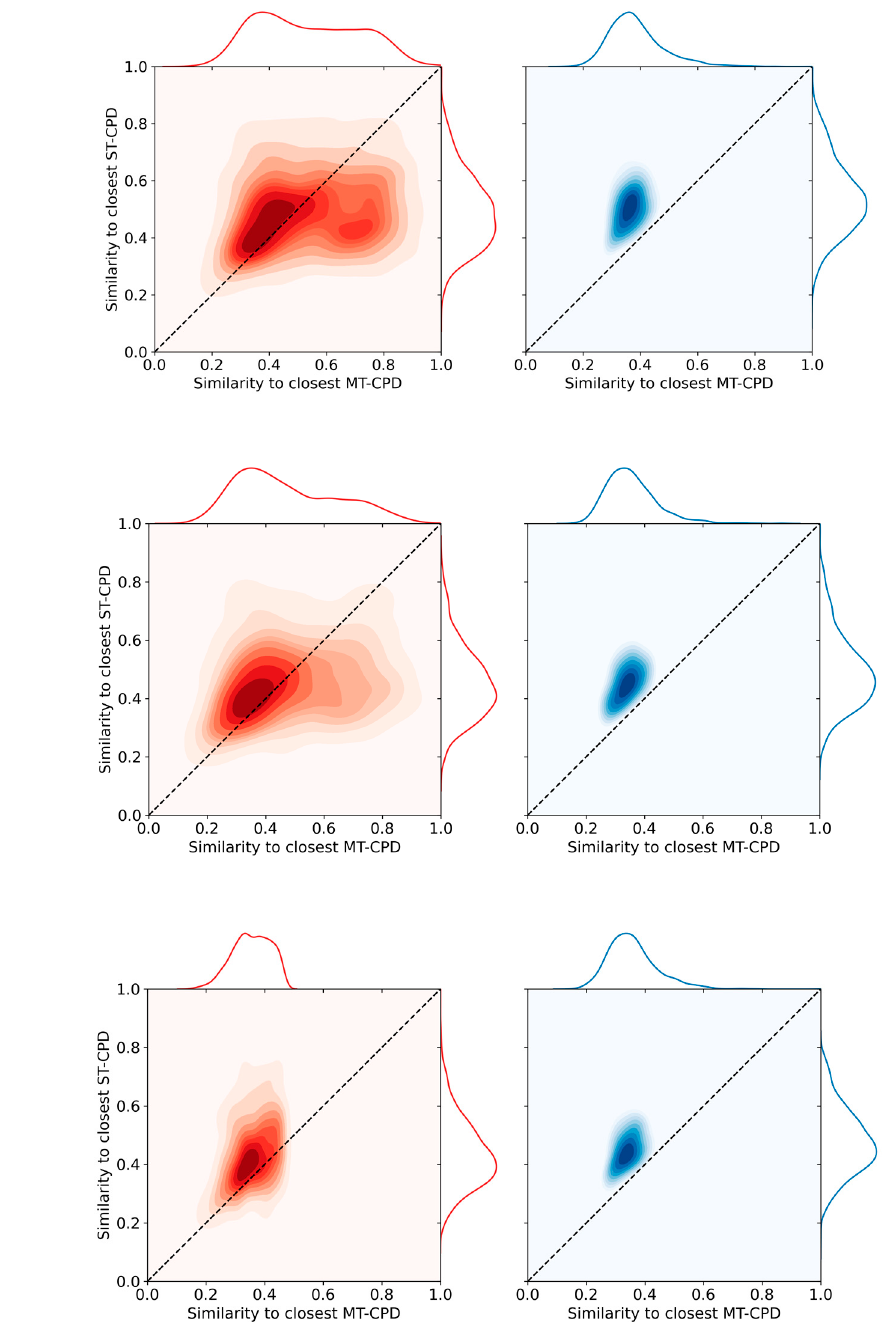
Figure 3. Nearest neighbor relationships for single- and multi-target compounds from mixed assays. KDE plots report the distribution of closest similarity relationships according to Figure 2. In ( a ), the similarity value distributions are reported for the original data set. In ( b , c ), NN calculations were carried out after random removal of 50% of the MT- and ST-CPDs and removal of 50% of the NNs from MT- and ST-CPDs,